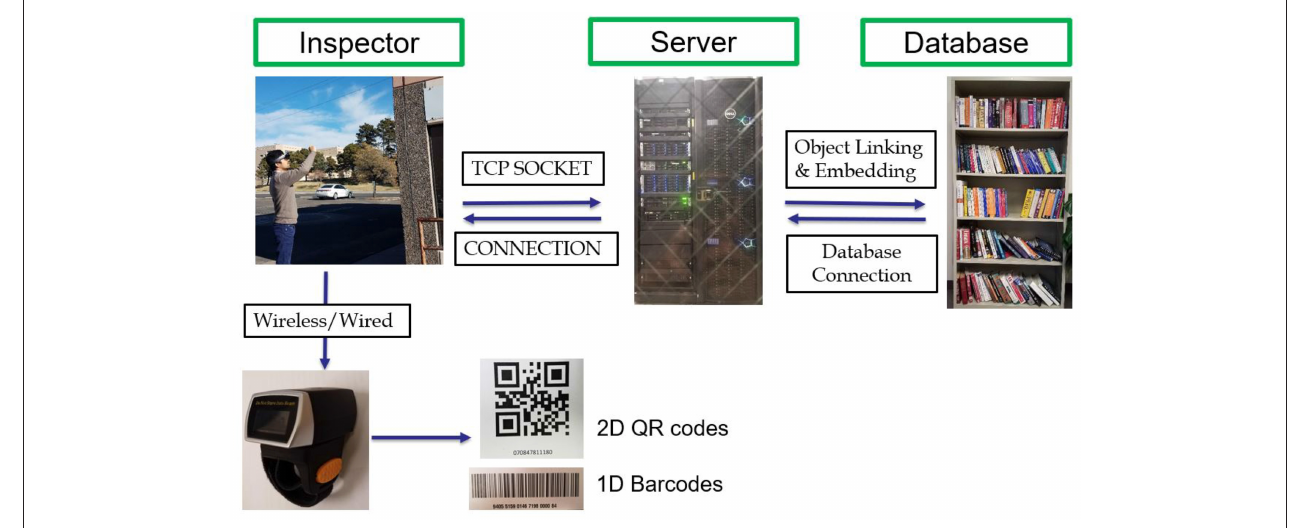
FIGURE 31 | Solution architecture.